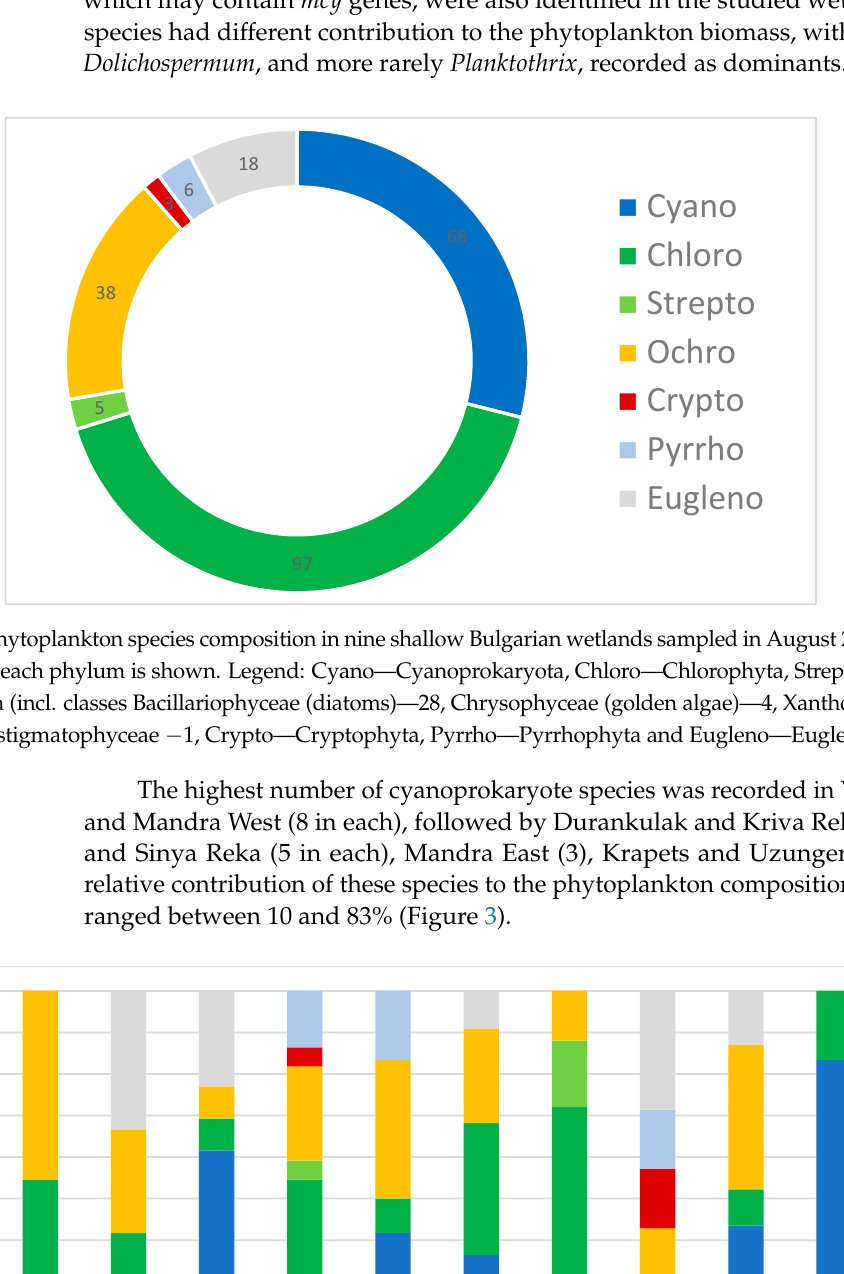
Figure 4. Relative contribution of different taxonomic groups to phytoplankton biomass, obtained by light microscopy, in the phytoplankton of the studied Bulgarian water bodies (August 2019). Legend: Mandra W—western part of the reservoir Mandra, Mandra E—eastern part of the reservoir Mandra; Cyano—Cyanoprokaryota, Chloro—Chlorophyta, Strepto— Streptophyta, Ochro—Ochrophyta (mainly diatoms), Crypto—Cryptophyta, Pyrrho—Pyrrhophyta and Eugleno—Eu ‐ glenophyta.